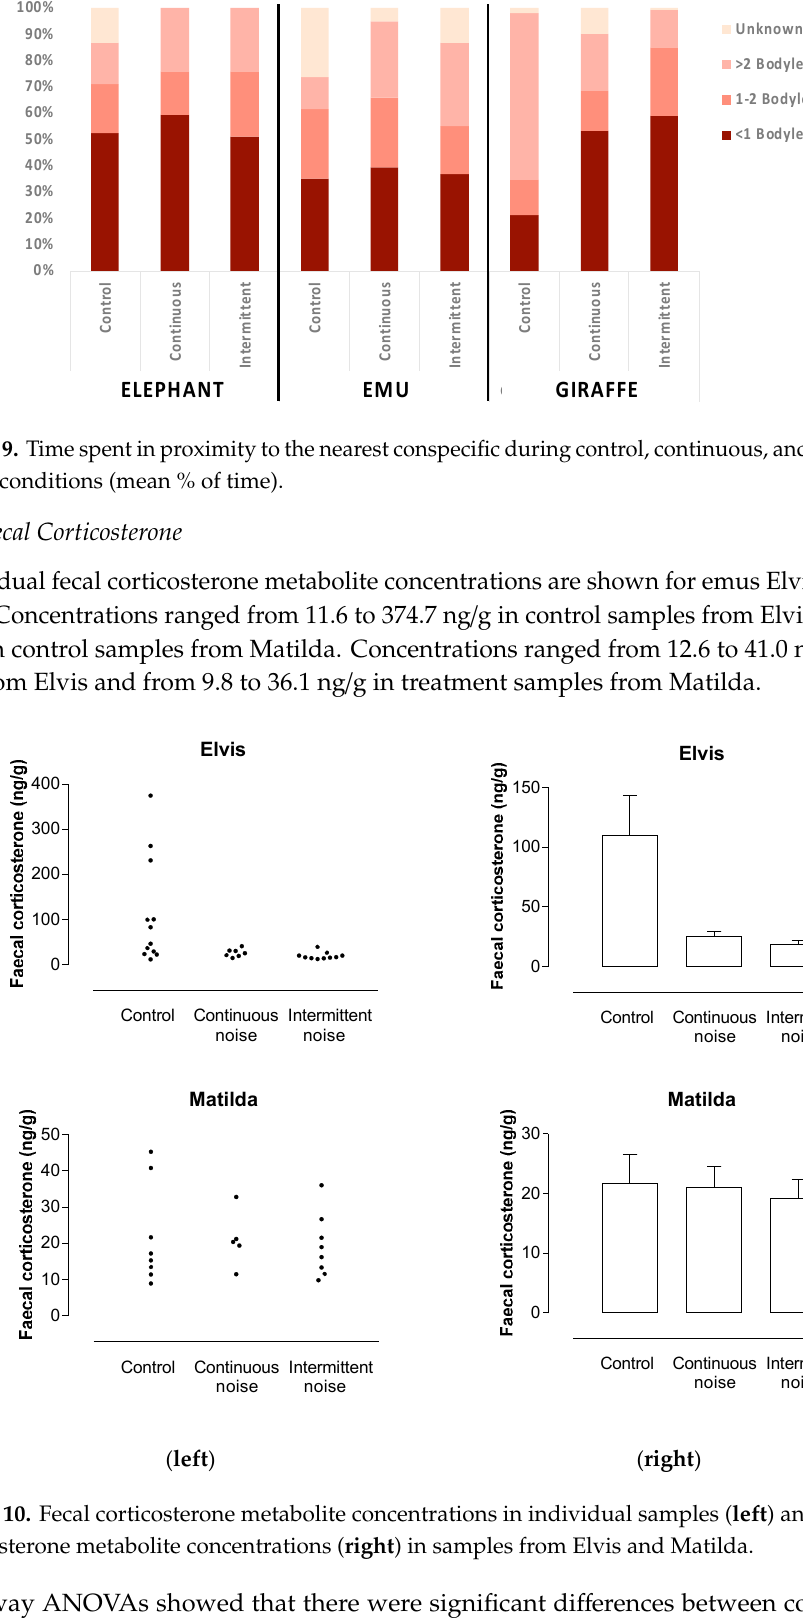
and intermittent noise conditions. (OSL = Out of Sight).